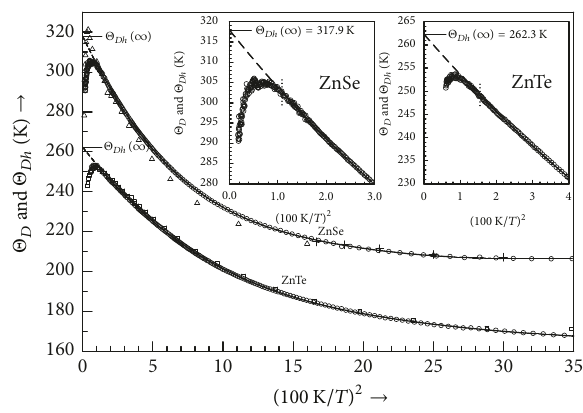
Figure 10: Fitting by means of (C.1) of the temperature dependen- cies of the harmonic sections (solid curves) of Debye temperature data, Θ 𝐷ℎ (𝑇) ≅ Θ 𝐷 (𝑇) , that were directly resulting from the high- accuracy transformations (via (27) or (28)) of the experimental 𝐶 (𝑇) data points provided by Kremer et al. ( I [46]), for natural 𝑝 ZnSe and ZnTe. The extrapolations of the harmonic (concave) Θ (𝑇) versus ∝ 𝑇 −2 curve sections to the 𝑇 → ∞ limit are 𝐷ℎ represented by dashed curve sections. For comparison we have also shown the more or less deviating Θ 𝐷 (𝑇) data points due to 𝐶 𝑝 (𝑇) data that have been available from earlier studies for ZnSe by Birch (+ [34]) and Sirota et al. ( △ [60]) and for ZnTe by Gavrichev et al. ( ◻[02 G ]